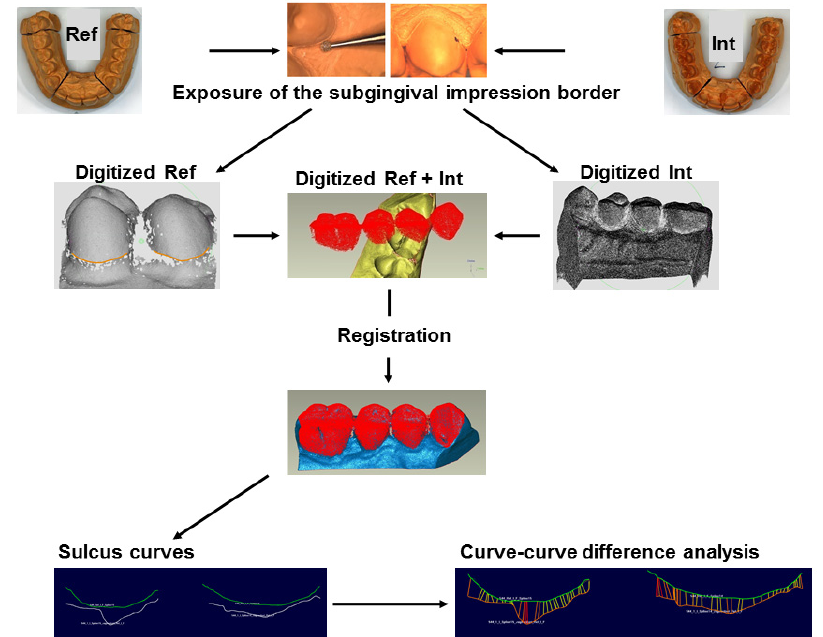
Figure 3. Sulcus representation analysis; Ref: Reference model; Int: Intervention model.